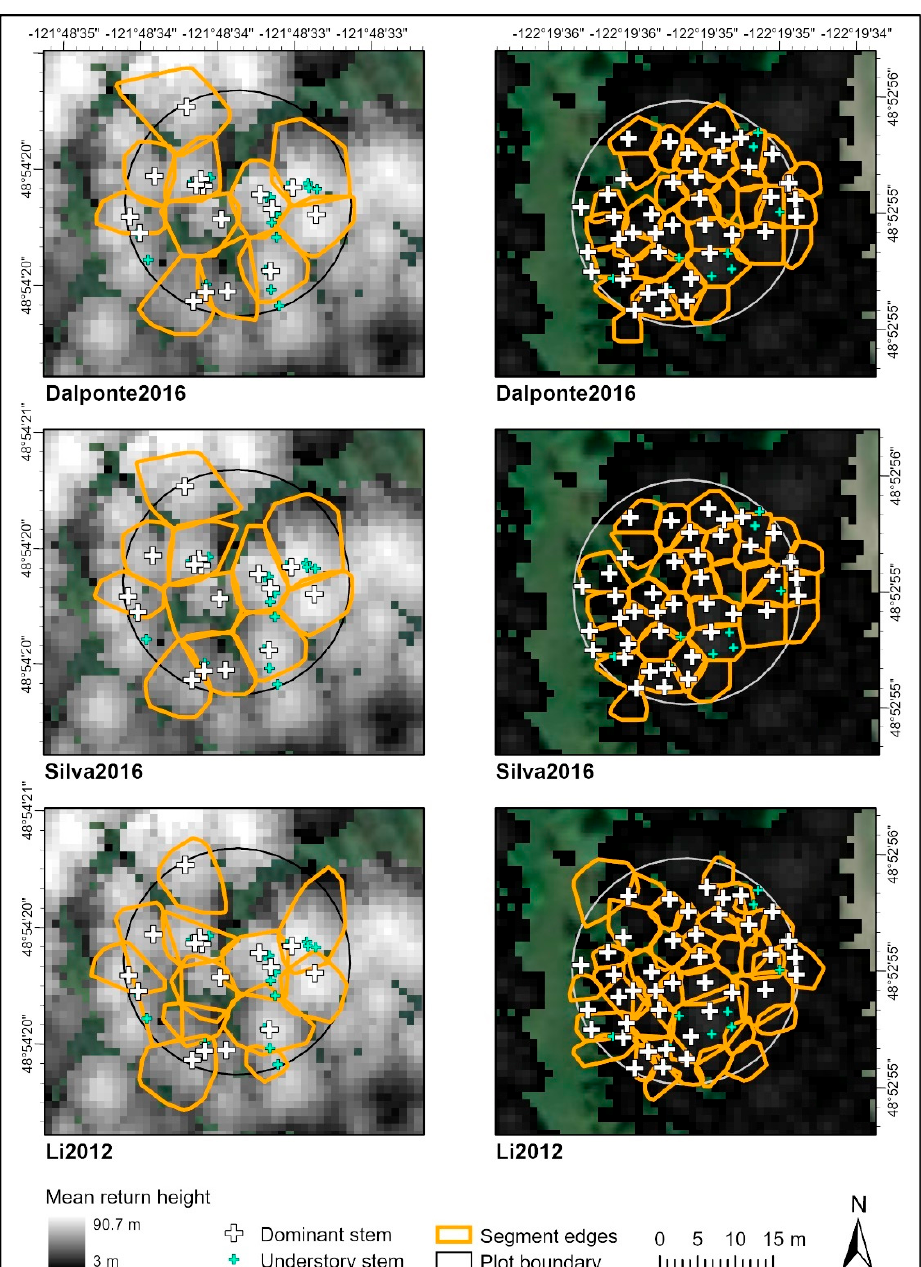
Figure 2. Examples of lidR segmentation outputs for a plot with large coniferous trees in the upper North Fork (left panels) and a plot with densely spaced small conifers on the lower main fork (right panels). Note that segments produced using the lidR packages can sometimes overlap each other.